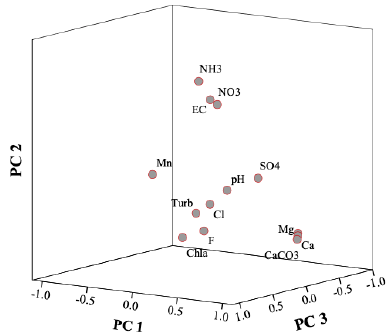
Figure 7. 3D biplot illustrating the relationship between highly correlated variables and the first three principal components. Source: PCA results from IBM SPSS Statistics [53].